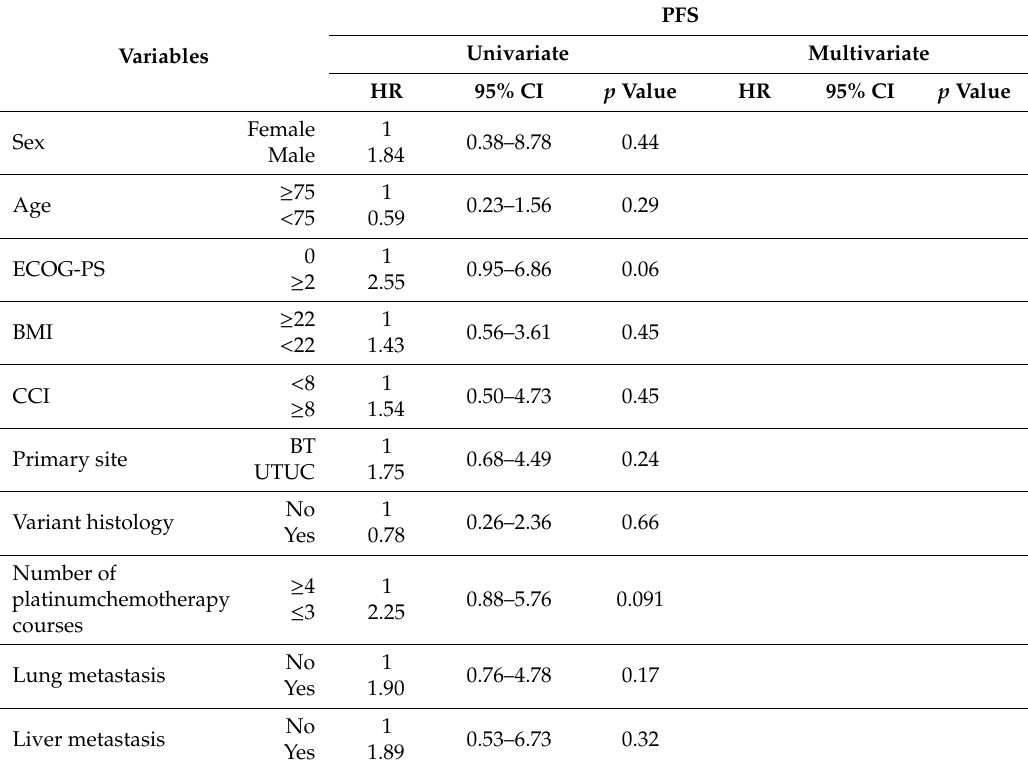
Table 2. Univariate and multivariate analysis of background factors for